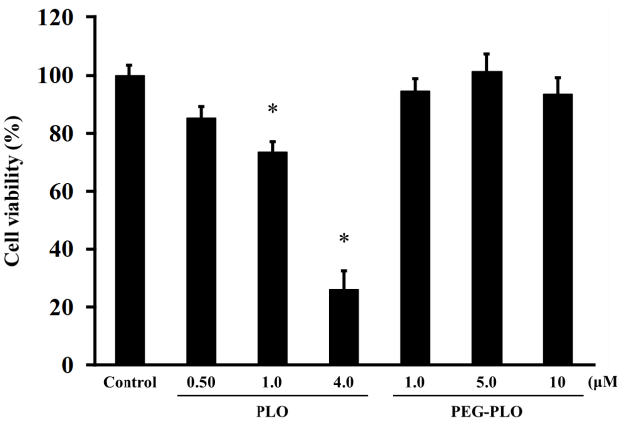
Figure 6. Effects of PLO and PEG-PLO on cell viability in Caco-2 cells. Control group was treated with vehicle (Hank’s balanced salt solution (HBSS)). Each data column represents the mean ± S.E. ( n = 3–4). * p < 0.05 compared with the control group.